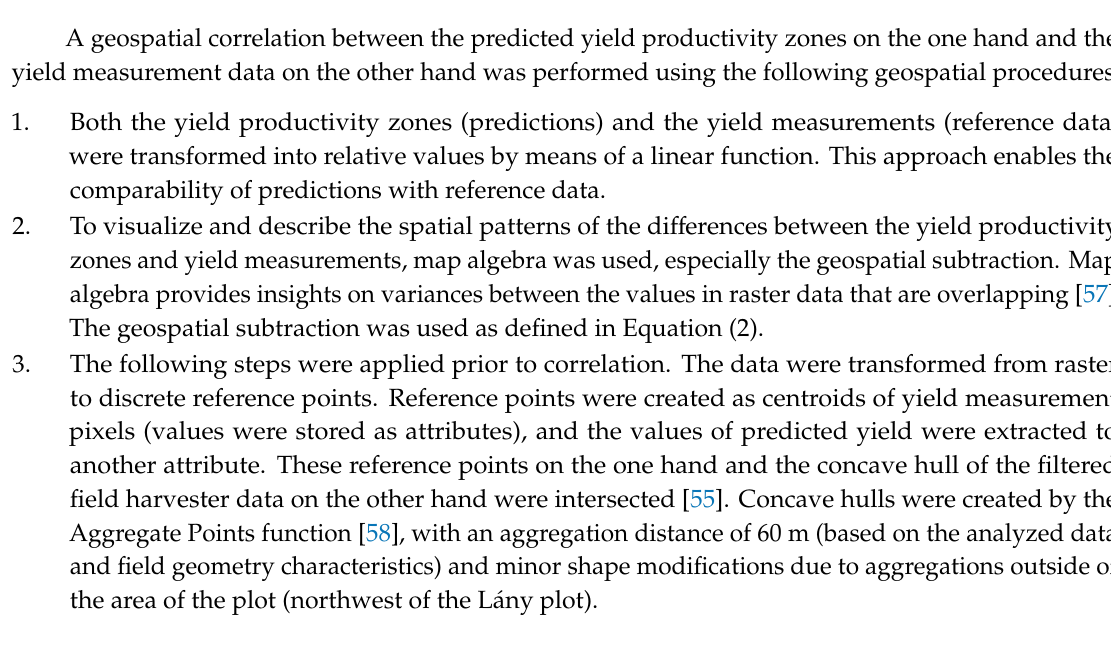
“Pivov á rka” plot (ID 2401 / 9) “Pˇredn í prostˇredn í ” plot (ID 2401 /